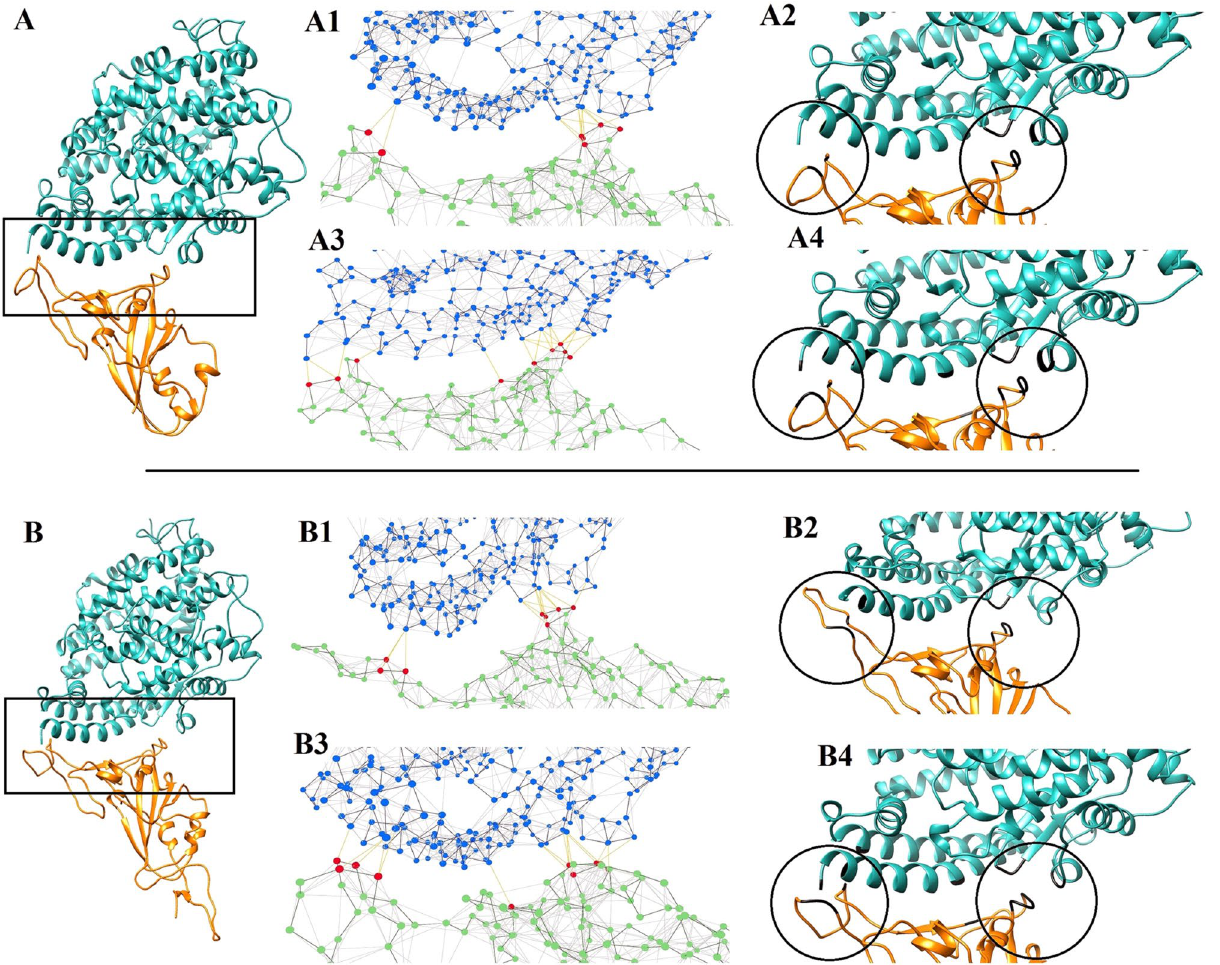
Figure 3. The interaction network analysis of ACE2-spike protein complex during the simulation: ( A ) in SARS- CoV (2ajf) and ( B ) SARS-CoV-2 (6m0j) structures. The PDB structures obtained from the initial (A1 and A2 for SARS-CoV, and B1 and B2 for SARS-CoV-2) and final (A3 and A4 for SARS-CoV, and B3 and B4 for SARS- CoV-2) 500 frames of the simulation that were analyzed by NAPS. The red points in A1, A3, B1 and B3 indicate critical amino acids that participated in the spike-ACE2 interaction The images have been obtained by UCSF Chimera 1.13.1 (http:// www. rbvi. ucsf. edu/ chime ra/) 47 and NAPS server (http:// bioinf. iiit. ac. in/ NAPS/) 24 . Δ G-